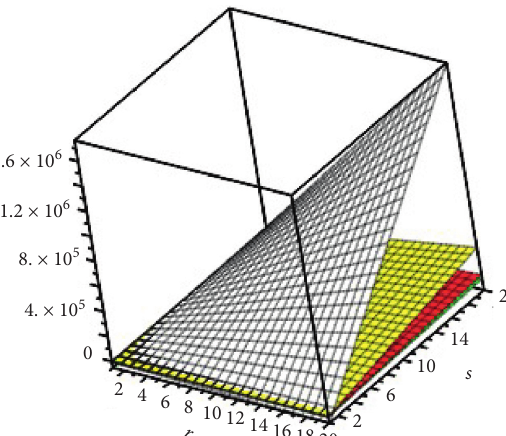
Figure 6: Comparison of GA index and GA fix t � 1. Red color represents GA , and green color represents GA